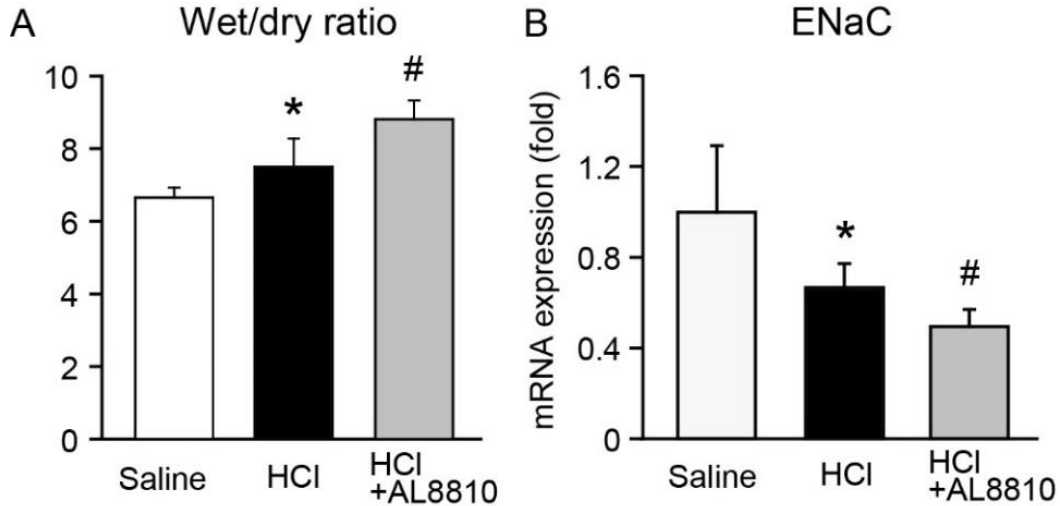
Figure 5. FP receptor antagonist promoted lung edema. AL8810 (10 mg/kg, i.p.) was administered to mice at 1 h before HCl (0.1 M, 2 µL/g, i.t.) administration. ( A ) Lung wet/dry weight ratio was calculated ( n = 6–7). ( B ) The gene expression levels of ENaC in the lungs of saline-, HCl-, and HCl+AL8810-treated mice were determined by qPCR ( n = 5–7). * p < 0.05 vs. saline, # p < 0.05 vs. HCl.